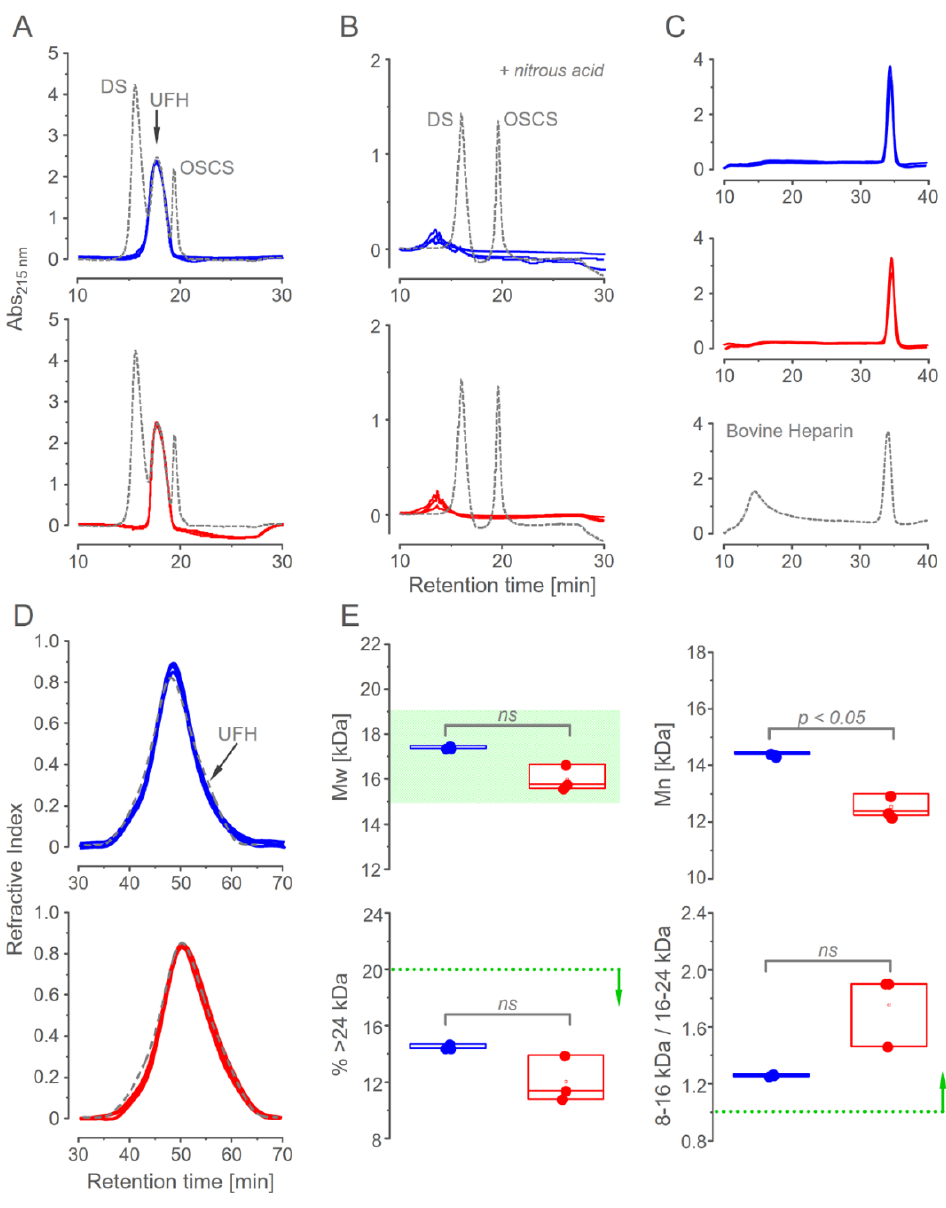
Figure 3. Chromatographic analysis of the pharmaceutical heparins. Ion-exchange chromatography: Overlapped elution profiles of three batches of heparin from each manufacturer 1 ( blue ) and manufacturer 2 ( red ), before and after deamination with nitrous acid, are shown in Panels ( A , B ), respectively. Black dotted lines show the elution of the standards of dermatan sulfate (DS), sodium heparin (UFH), and oversulfated chondroitin sulfate (OSCS). Panel ( C ) shows the elution from a strong anion exchange column using step-wise salt gradient of the pharmaceutical heparins in comparison with bovine heparin ( dotted gray line ) for assessing their homogeneities. Panels ( D , E ): Size-exclusion chromatography. Overlapped elution profiles of the heparins from manufacturers 1 and 2 and the “Heparin sodium molecular-weight calibrant” ( dotted-black line ). Experimental data were used to calculate the parameters of average molecular mass (M w ), mean molecular mass (M n ), and the distri- bution of heparin molecules by molecular mass ranges, as shown in Panels ( E ). The acceptance criteria established by USP are indicated in green and dotted lines + vertical arrows. Ns , non-significant; p < 0.05, significant differences; and t,